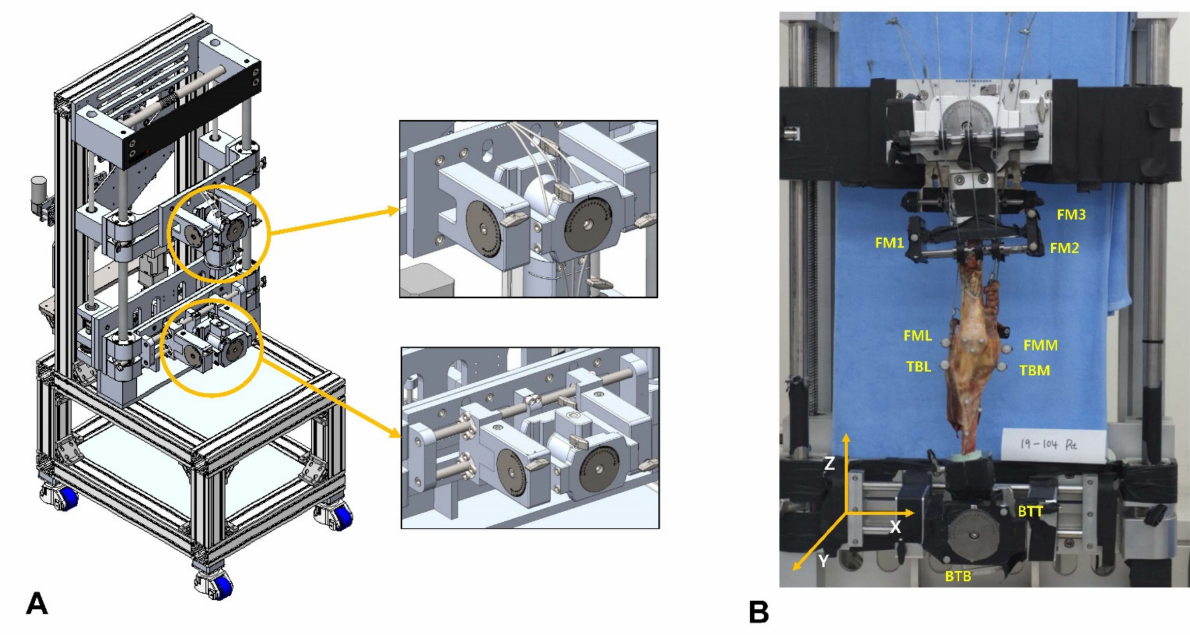
Figure 2. Schematic of the knee-squatting simulator with six degrees-of-freedom ( A ) and locations of the optical markers ( B ) on the femur (FML and FMM); tibia (TBL and TBM); and RIG system (FM1, FM2, and FM3 BTT and